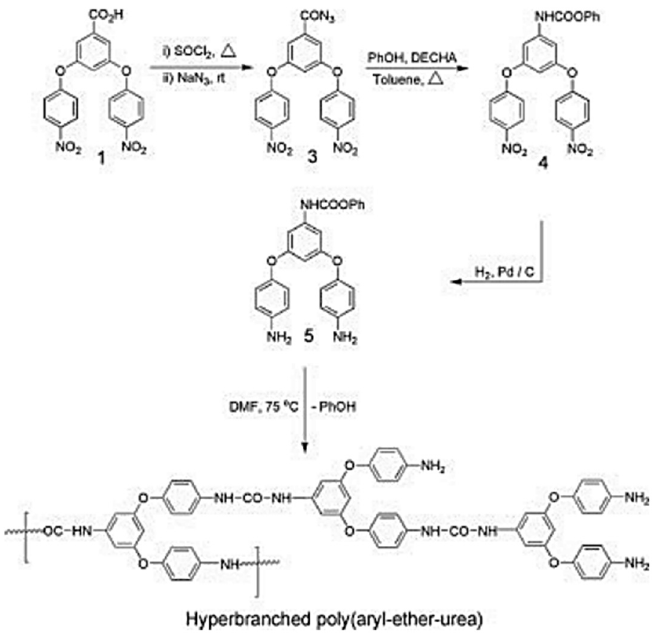
Figure 9. Synthesis of AB 2 -type blocked isocyanate monomer and corresponding hyperbranched poly(aryl-ether-urea). From reference [41].